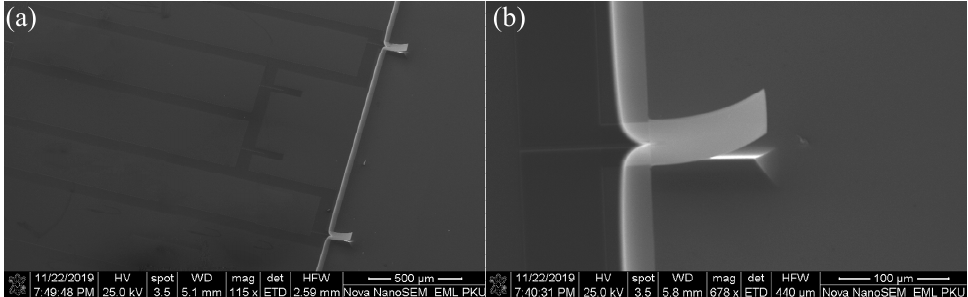
Figure 3. ( a , b ) are SEM photos of a microcantilever array and a single microcantilever, respec ‐ tively.